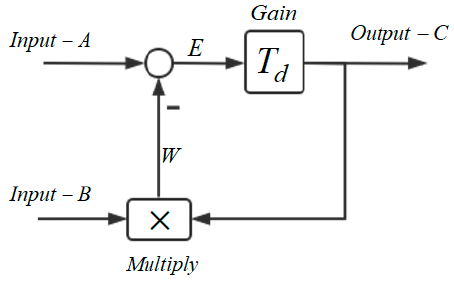
Figure 12. The structure of the division gate.